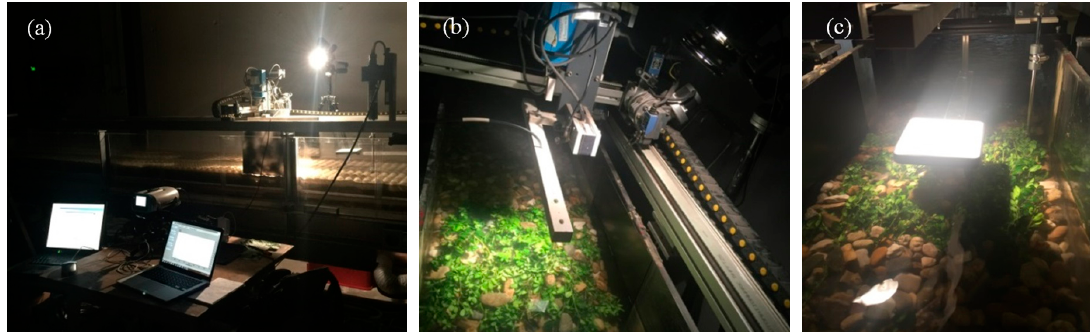
Figure 3. (a) The setup for spectroscopic experiments on the hydraulic flume and the spectral measurements of (b) SAV with high density and (c) the white reference. The spectral reflectances were recorded from above the water surface within the 325–1075 nm range using a fiber optic cable connected to an ASD HandHeld 2 spectroradiometer.